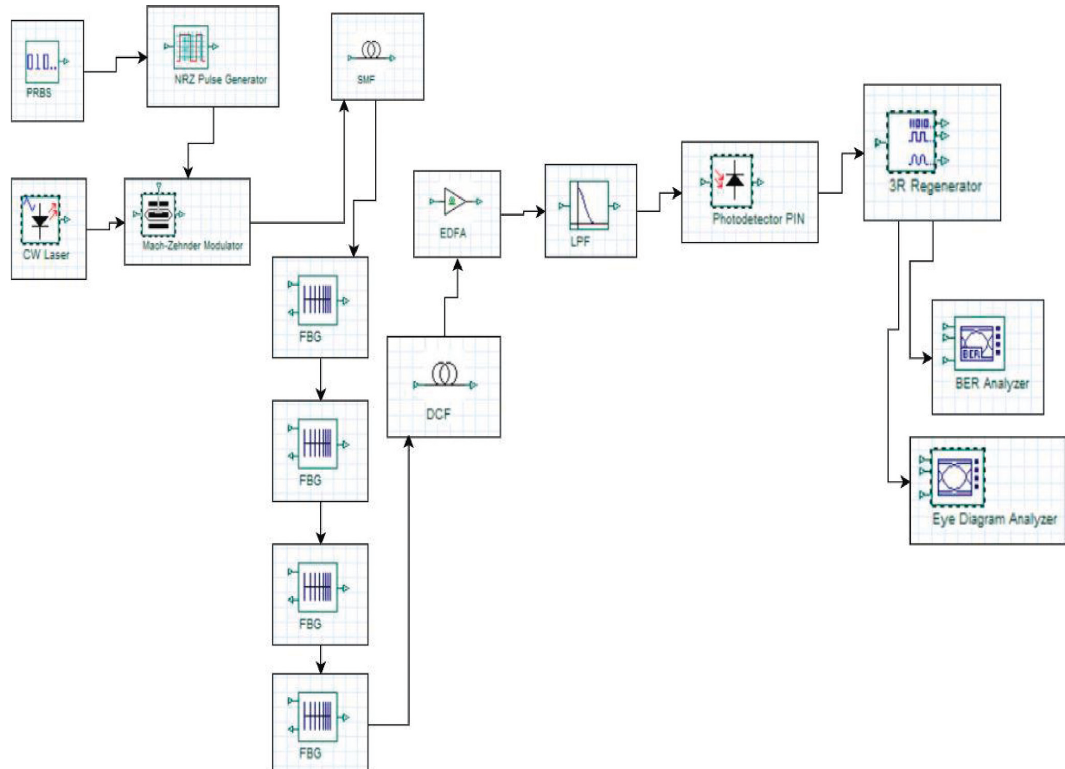
Figure 3: A cascade of four stage FBG and DCF simulation model at 100km of